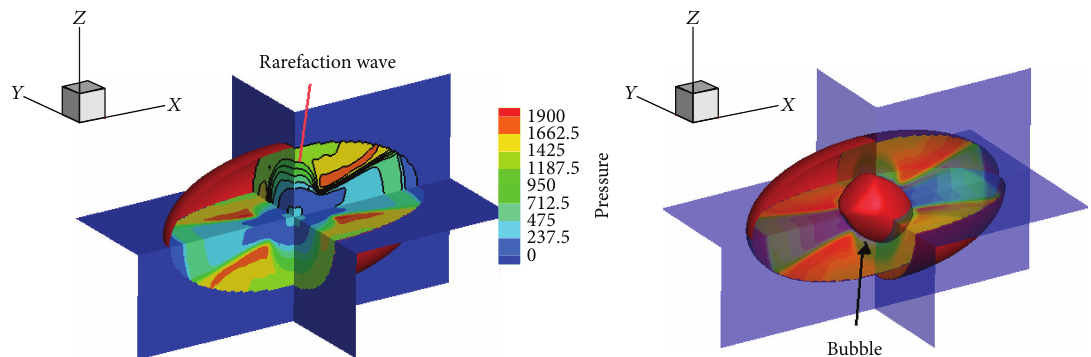
Figure 16: Numerical results by GFM-based algorithm 𝑡 = 0.437 ms. Left: pressure cloud pictures and pressure contours, right: bubble shape (Case 6).